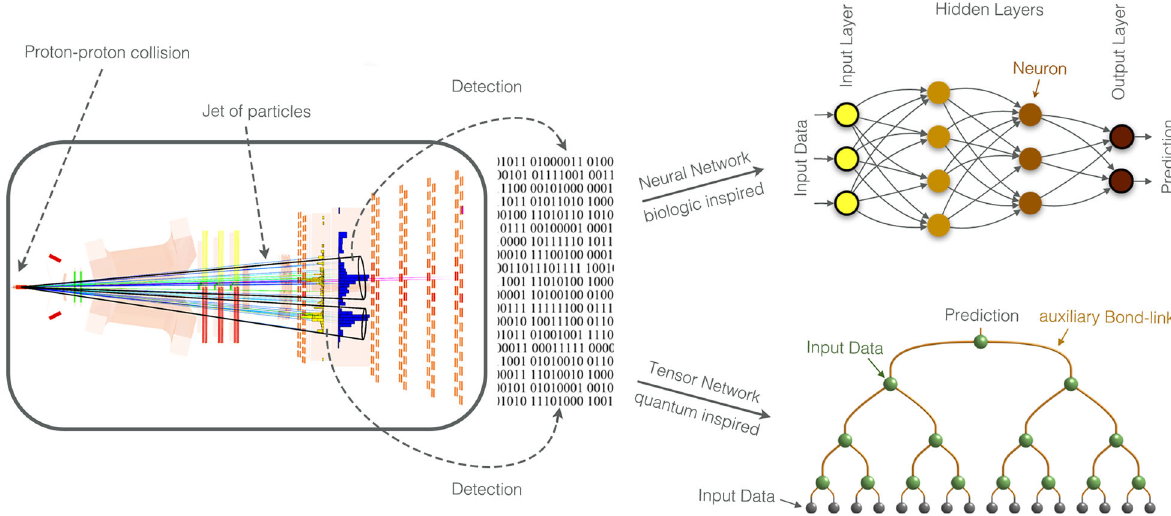
Fig. 1 Data fl ow of the Machine Learning analysis for the b -jet classi fi cation of the LHCb experiment at CERN. After proton – proton collisions, b - and b -quarks are created, which subsequently fragment into particle jets (left). The different particles within the jets are tracked by the LHCb detector. Selected features of the detected particle data are used as input for the Machine Learning analysis by NNs and TNs in order to determine the charge of the initial quark